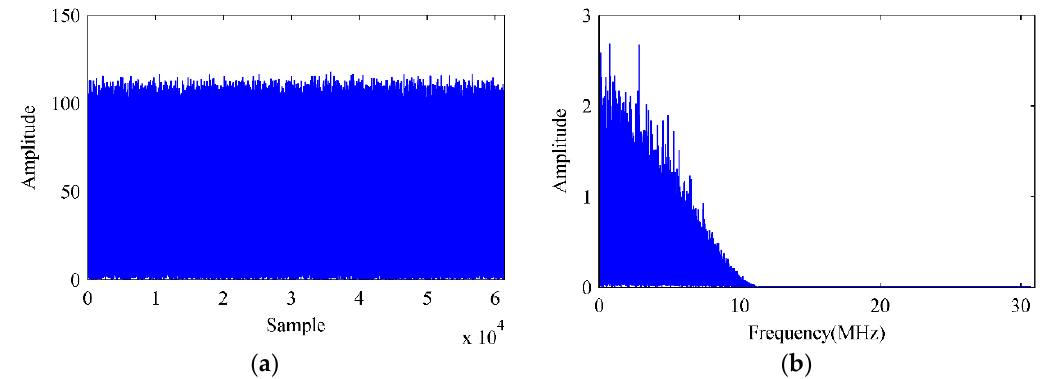
Figure 6. Time domain samples and single ‐ sided amplitude spectrum of the input baseband signal. ( a ) Time domain samples. ( b ) Single ‐ sided amplitude spectrum.